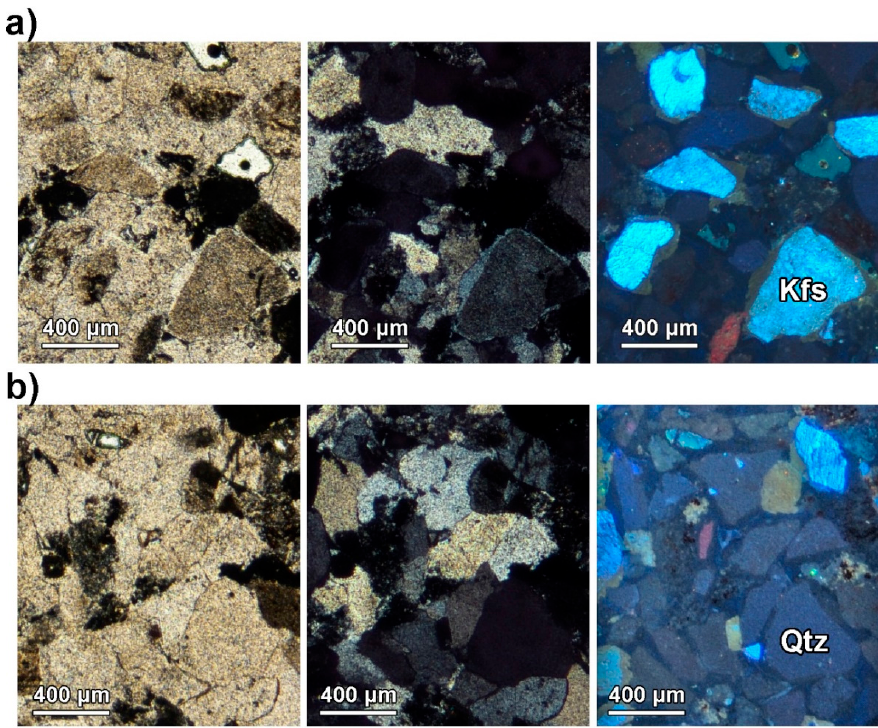
Figure 2. Petrographic images of two samples of Montjuïc sandstone from the Castell Unit corresponding to macroscopic sample C1 (in Figure 5). Images include plane polarized light, PPL (left), cross polarized light, XPL (middle), and cathodoluminescence, CL (right) micrographs of the same areas. ( a ) K-feldspar (Kfs) clasts show distinguishable authigenic overgrowths, ( b ) quartz (Qtz) clasts also have authigenic overgrowths but these are only exposed using CL microscopy, shadows have been adjusted in the CL micrograph to emphasize quartz overgrowths.